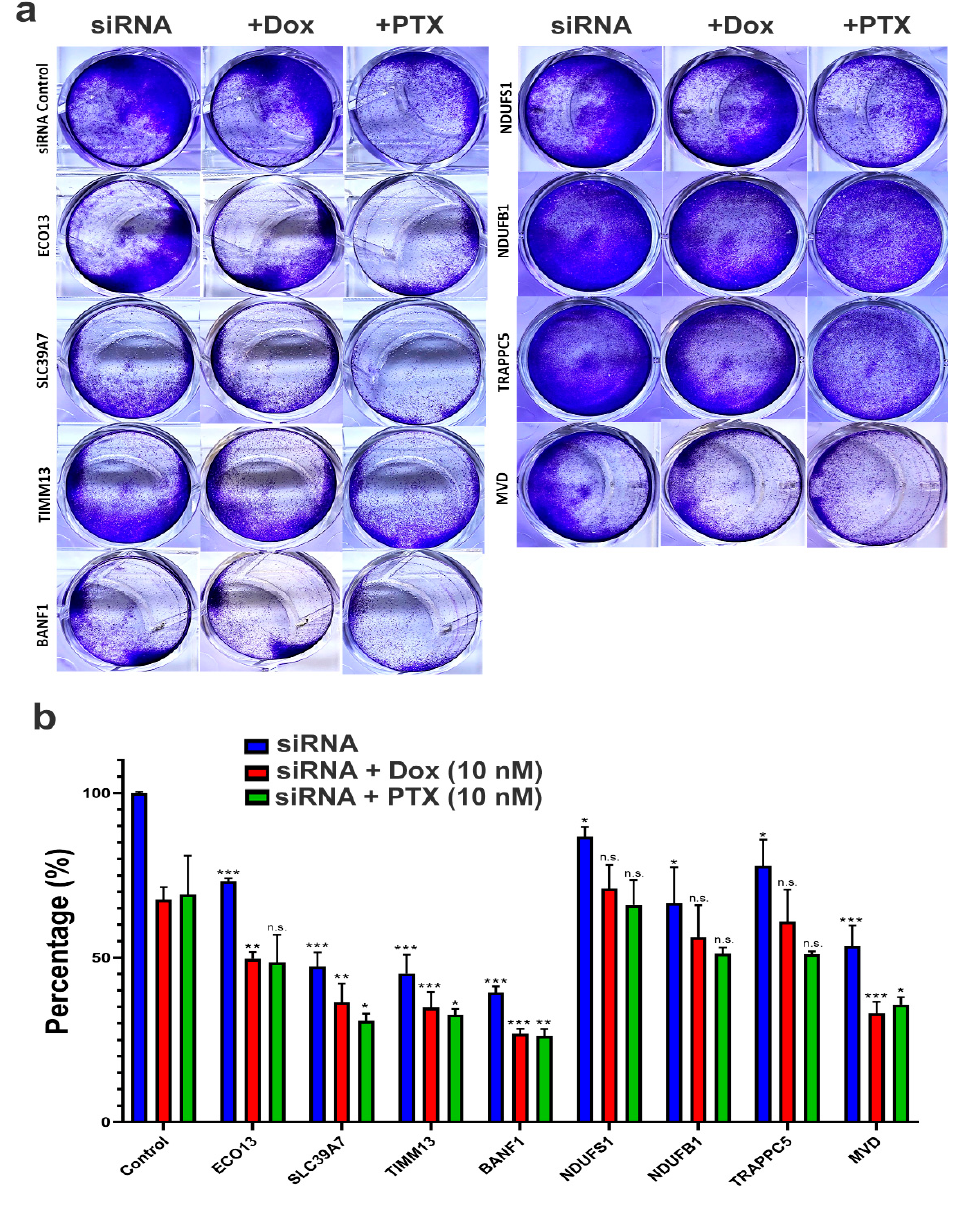
Figure 3. Effects of RD-genes knockdown on MDA-MB-231 CFU and viability. ( a ) Representative image showing CFU potential of MDA-MB-231 cells on day 7 post transfection with siRNA targeting ELOB, SLC39A7, TIMM13, BANF1, NDUFS1, NDUFB7, TRAPPC5, and MVD as a single treatment modality or in combination with doxorubicin (10 nM) or paclitaxel (10 nM). ( b ) Quantification of CFU from two independent experiments. Data are presented as the mean ± S.E., n = 6. * p < 0.05, ** p < 0.005, *** p < 0.0005, n.s.: not significant. Each treatment was compared to the corresponding control condition.